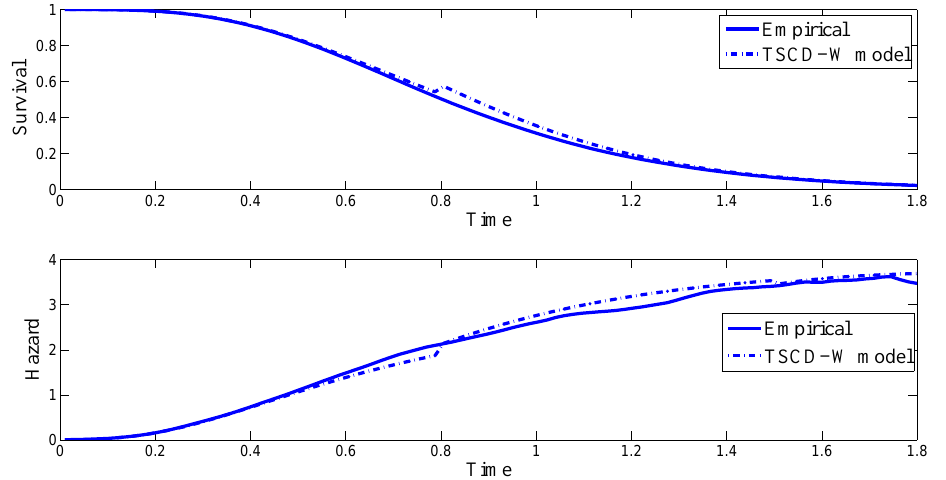
Figure 1. Top Panel : conditional survival function of the TSCD-W model for the simulated durations and its empirical survival function. Bottom Panel : the corresponding conditional hazard function for the simulated data and its empirical hazard